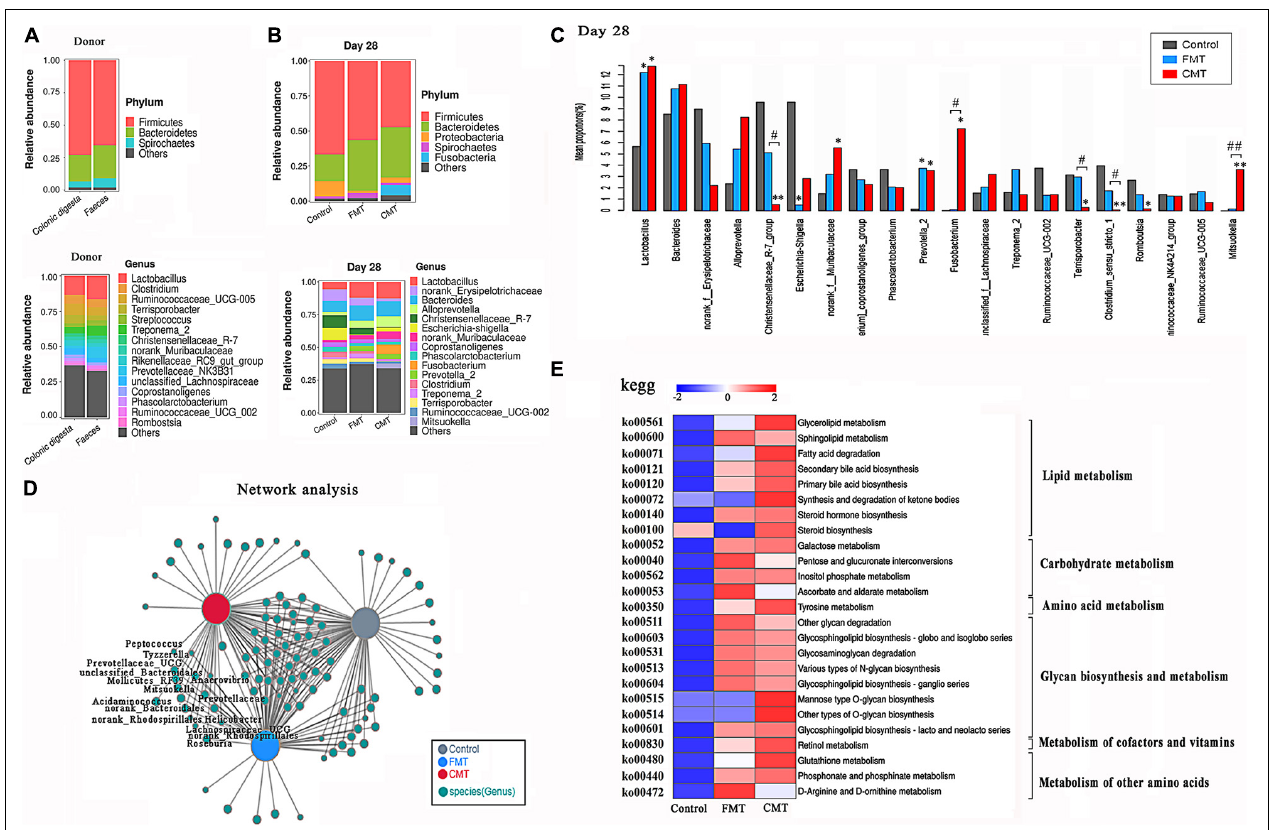
FIGURE 6 | Microbiota transplantation optimized the structure of the intestinal microbiota. (A) Bacterial composition profiles of the feces and colonic digesta of the adult donor pig at the phylum and genus levels ( n = 3). (B) Bacterial composition profiles of the feces of the piglets at the phylum and genus levels ( n = 6). (C) The differences in the 20 top bacteria genera with high abundance between different piglets were compared by the Kruskal–Wallis test ( n = 6); ** indicates P < 0.01, and * indicates P < 0.05 compared with the control; ## indicates P < 0.01, and # indicates P < 0.05 between the FMT and CMT groups. (D) Co-occurrence network analysis of the gut bacteria (genus level) in different piglets on day 28. (E) Comparison of the abundances of KEGG pathways (metabolism, level 3) in different pigs. The functional contributions of the gut microbiota were assessed using the PICRUSt2 tool. Red indicates a high level, and blue indicates a low